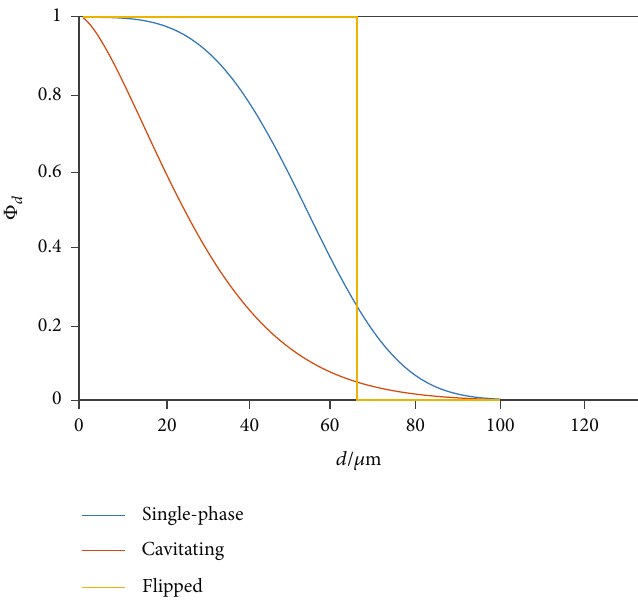
Figure 4: Initial droplet size distribution of di ff erent fl ow states.